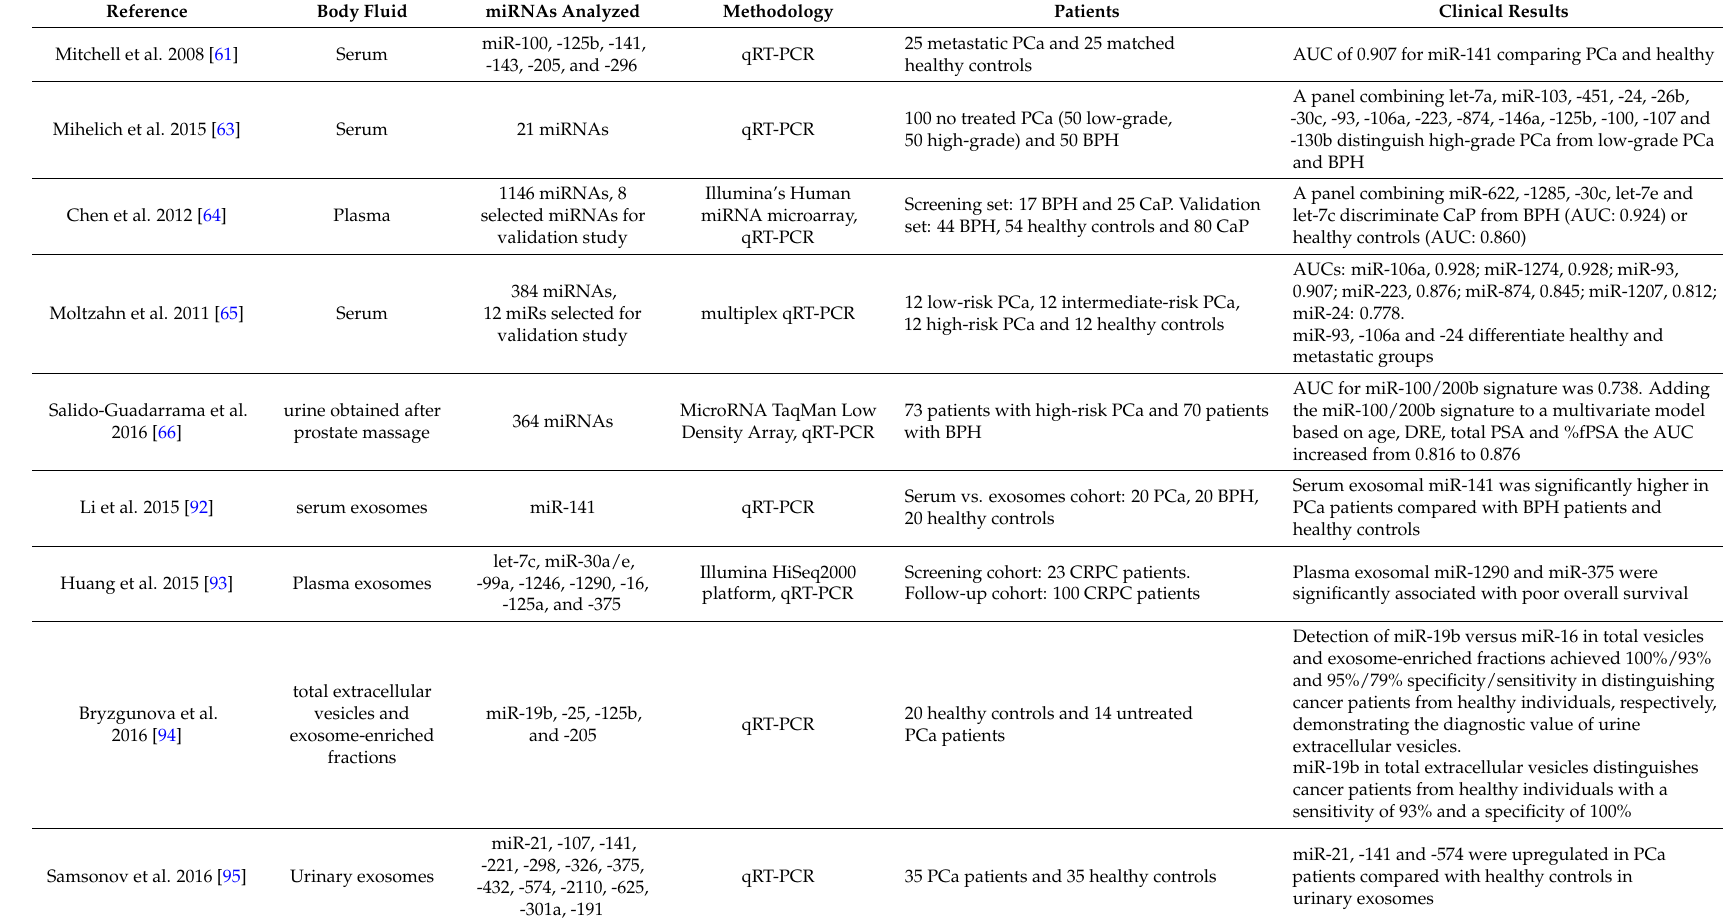
Table 1. microRNAs studies in PCa